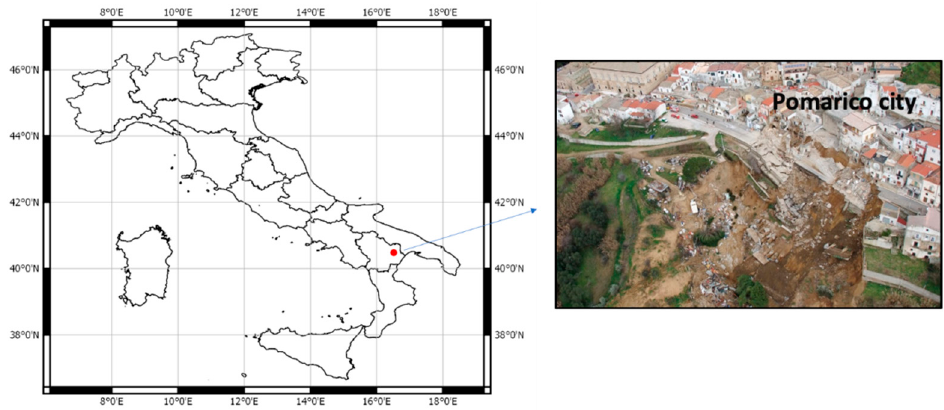
Figure 1. Pomarico city (MT) landslide location.